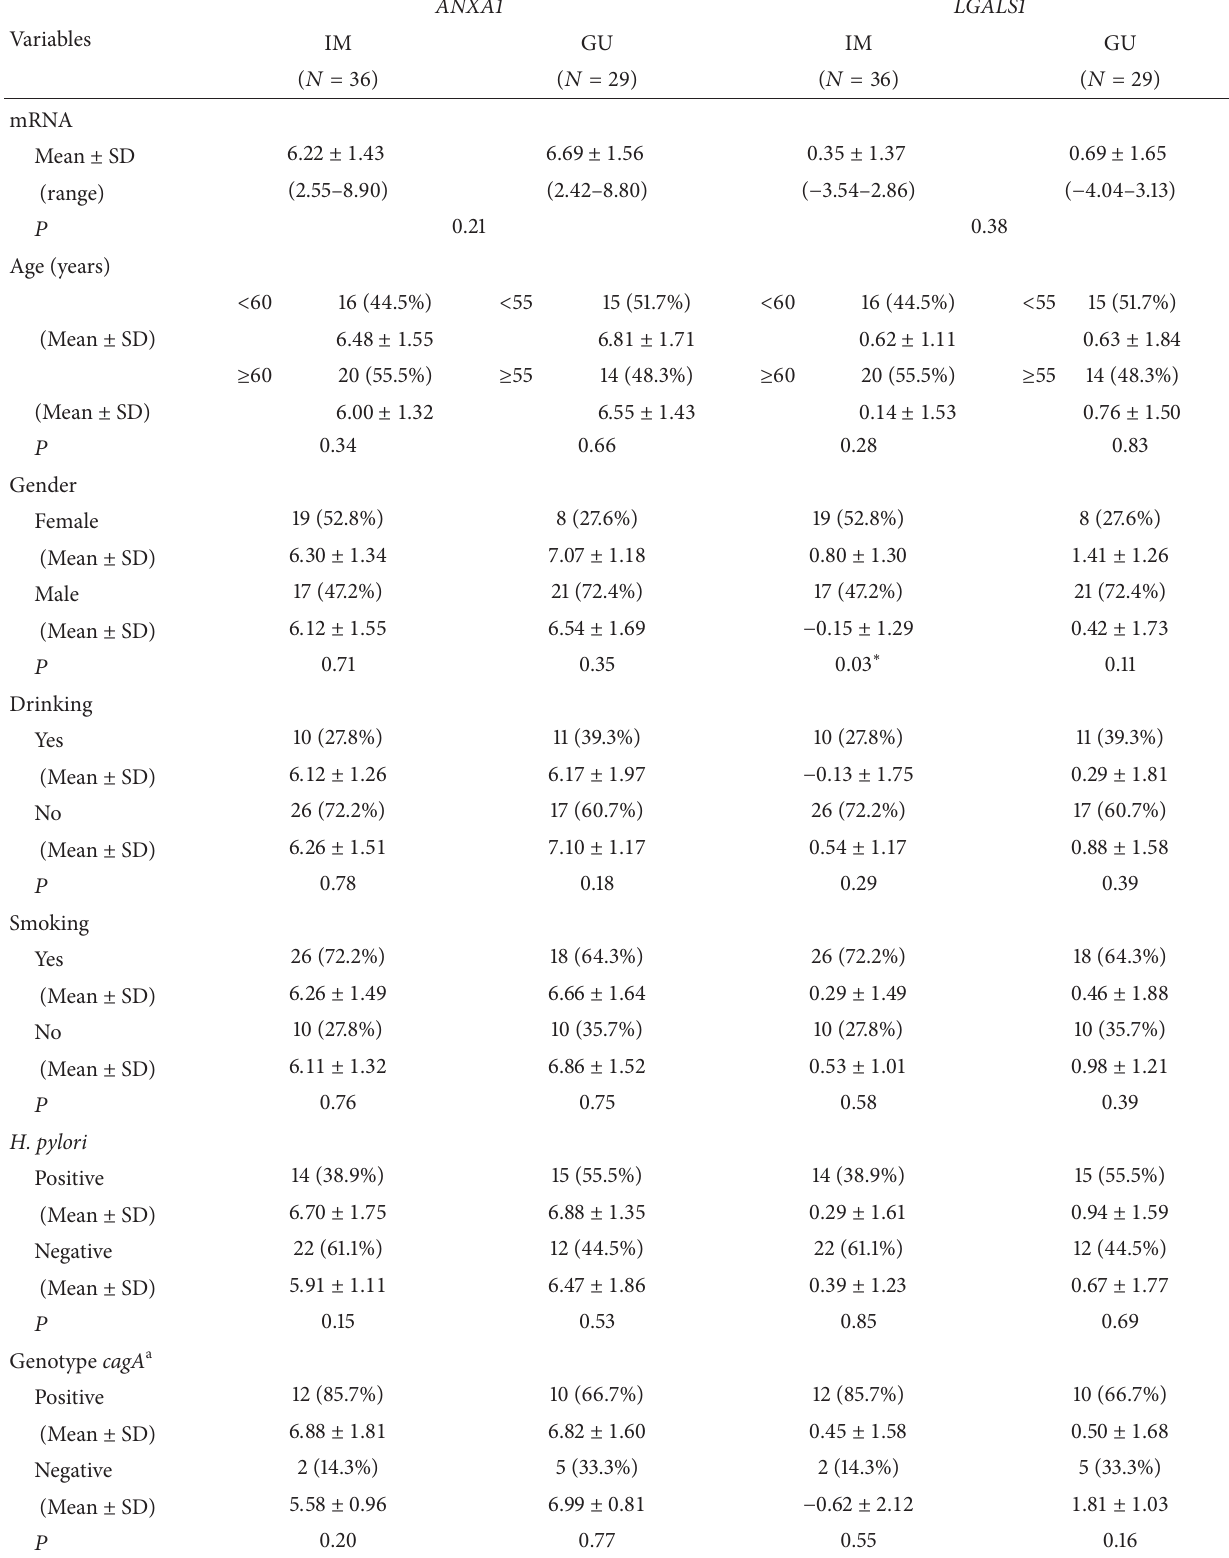
Table 2: Relative gene expression of ANXA1 and LGALS1 mRNA in the intestinal metaplasia (IM) and gastric ulcer (GU) groups and comparison according to risk